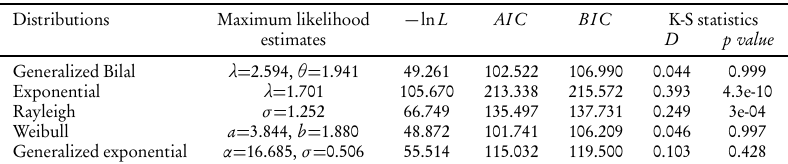
Summary fit to the real data set